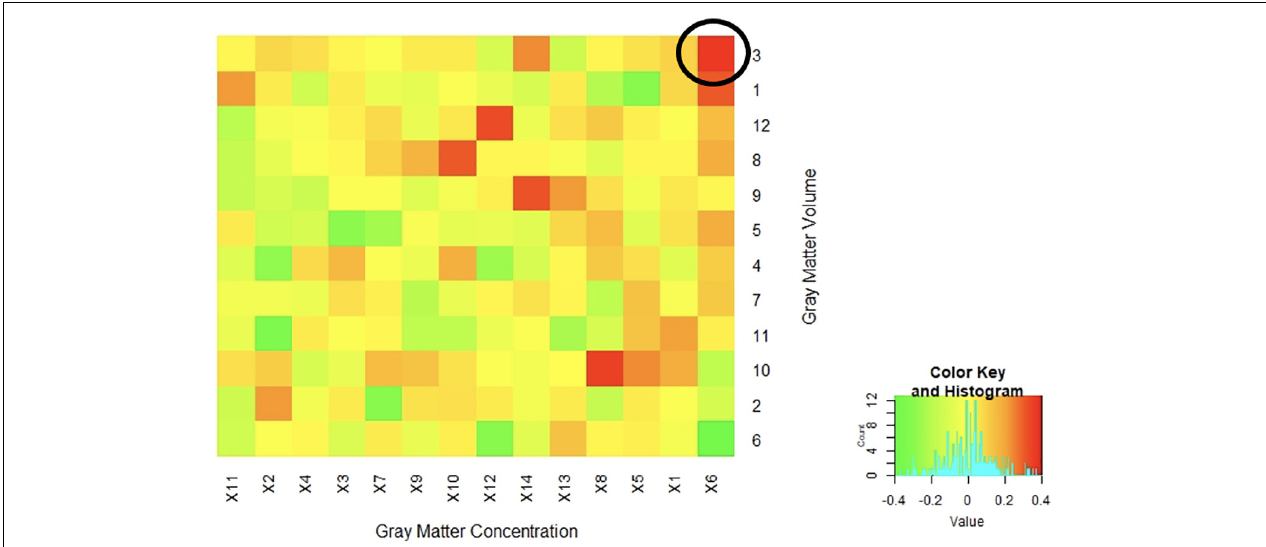
FIGURE 4 | Correlations between Concentration and Volume ICA Components Correlations between the z-weights in the spatial patterns of the gray matter concentration (x axis) and volume (y axis) ICA components from SBM analysis were low to moderate. The highest positive correlation was between spatial patterns in the cerebellum and vermis ( r = 0.37) circled in the above figure. The majority of the correlations fell between − 0.20 < r < 0.20 indicating a generally low overlap between the identified regional patterns.